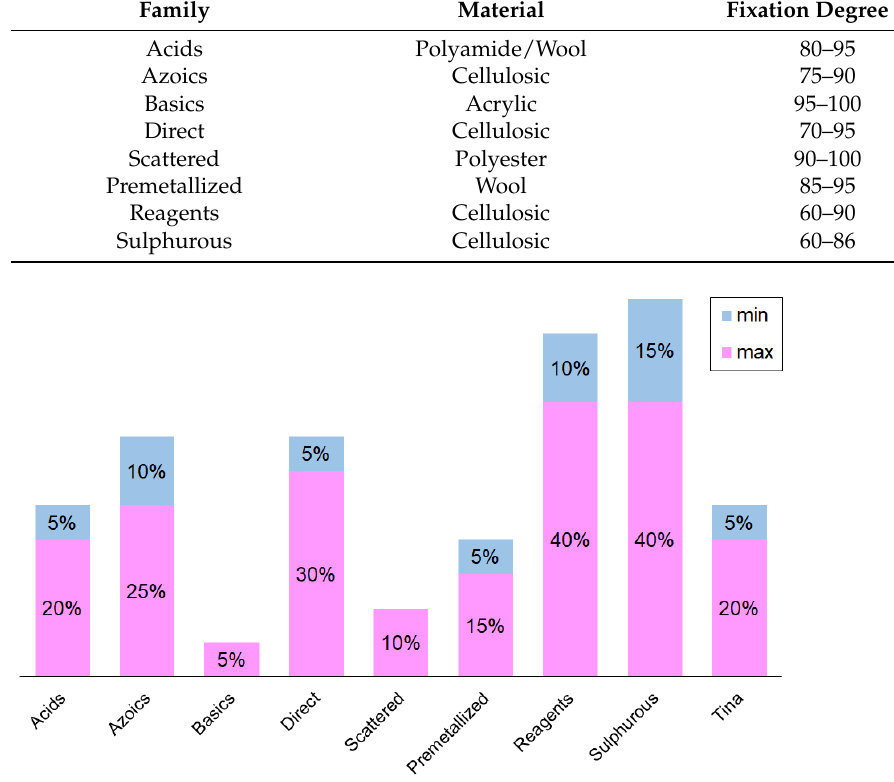
Figure 1. Loss in the effluent percentage.